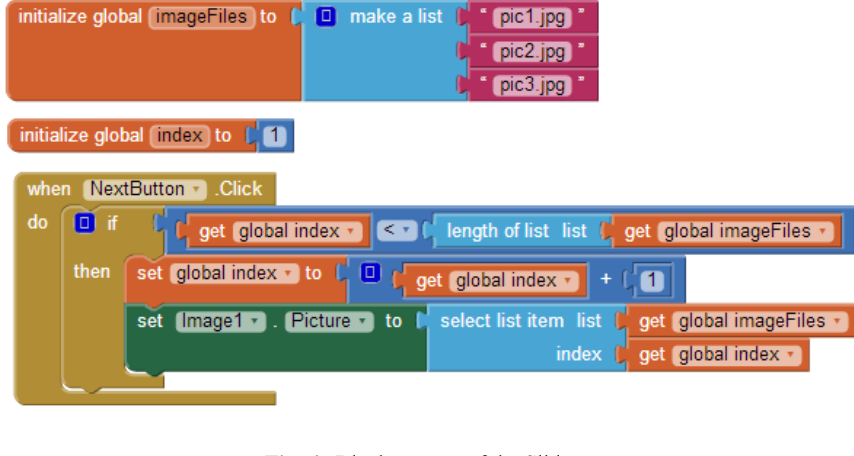
Fig. 6. Blocks screen of the Slides